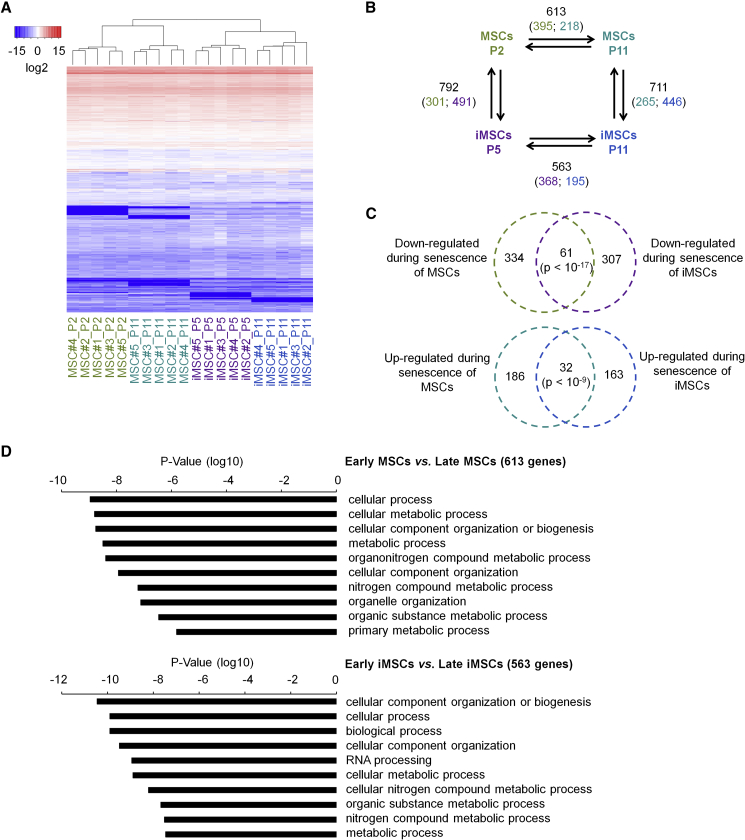
Transcriptome Analysis of Replicative Senescence(A) Heatmap of the entire transcriptome of MSCs and corresponding iMSCs (n = 5, donor numbers are indicated). Hierarchical clustering clearly separated early and late passages for both cell types.(B) The numbers of transcripts with significant gene expression changes in pairwise comparisons are depicted (2-fold differential expression and limma adjusted p < 0.05; the number of upregulated genes in the corresponding cell type is indicated by color code).(C) The Venn diagrams depict significant overlaps of down- and upregulated transcripts during senescence of MSCs and iMSCs (significance was estimated by hypergeometric distribution).(D) The senescence-associated gene expression changes in MSCs and iMSCs were classified by Gene Ontology analysis. Functional categories involved in metabolic processes were among the most significantly overrepresented (Fisher t test).